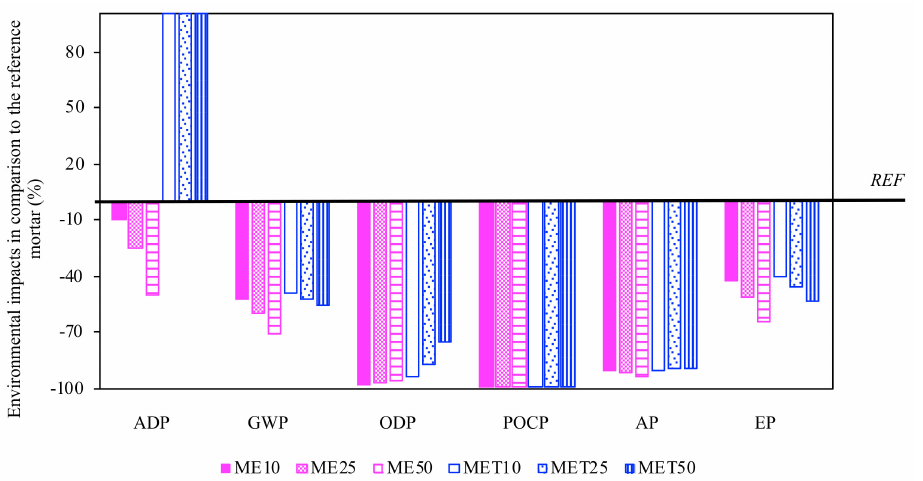
Figure 2. Environmental impacts mitigation of mortars produced with treated mining residues, compared to the reference mortar baseline. ADP—Abiotic Depletion Potential; GWP—Global Warm- ing Potential; ODP—Ozone depletion Potential; POCP—Photochemical Ozone Creation Potential; AP—Acidification Potential; and EP—Eutrophication